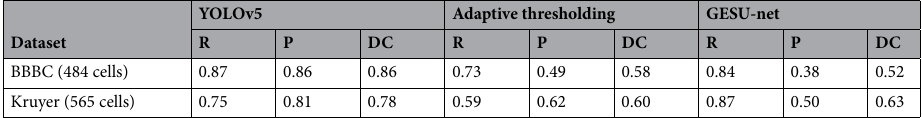
Table 1. Astrocyte detection performance corresponding to best Dice coefficient of our algorithm based on YOLOv5, Adaptive Thresholding and GESU-net 31 . Performance metrics include Recall (R), Precision (P) and Dice Coefficient